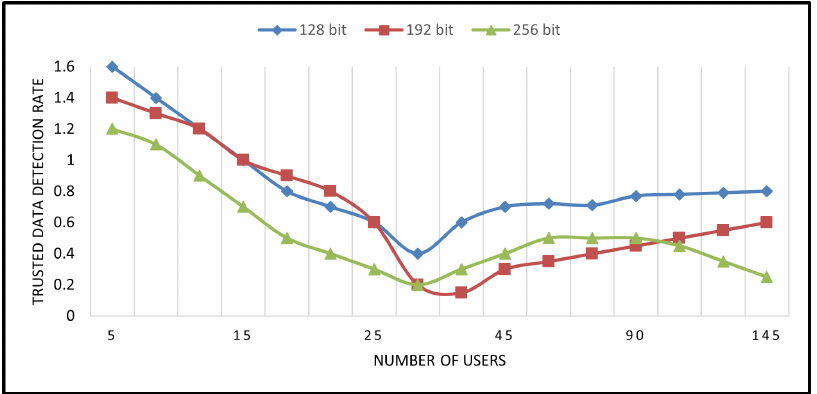
Figure 10. Detection of trusted data shared by the user using the interface layer.